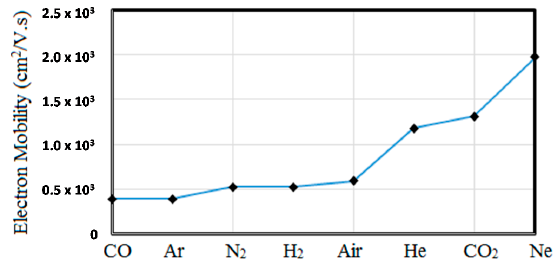
Figure 4. Electron mobility in plasma of different gases used in MPDs.